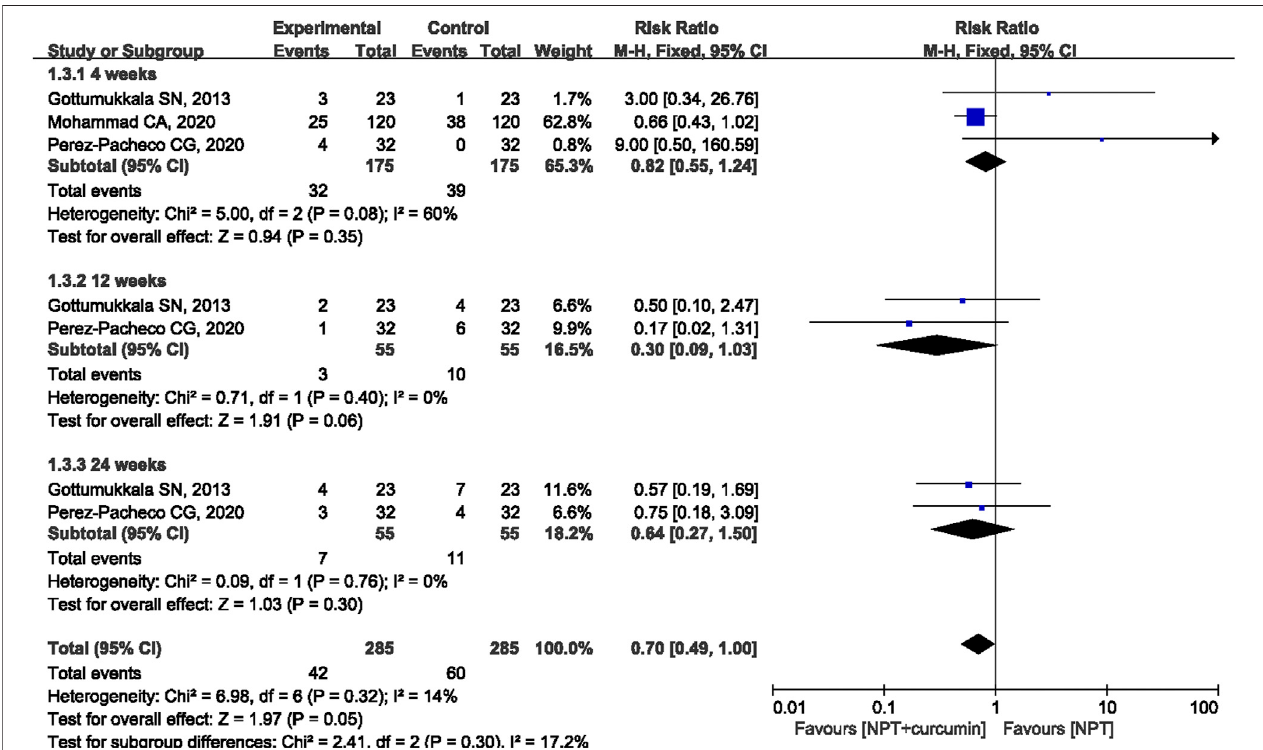
FIGURE 6 | Forest plot of the effects of curcumin + NPT versus NPT on